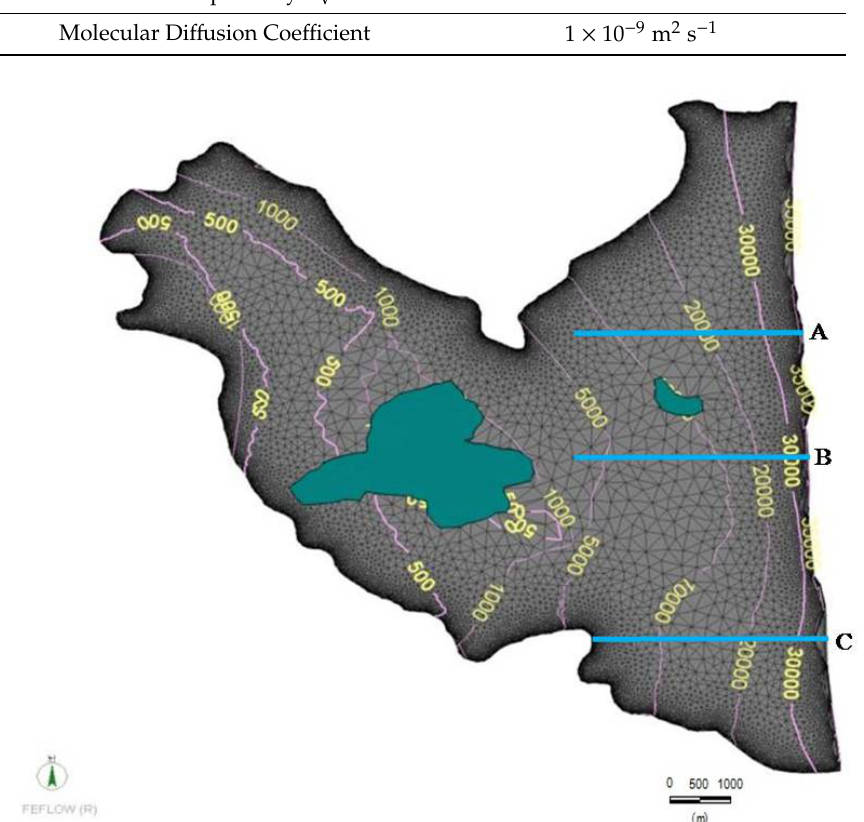
Figure 8. Salinity distribution set up in the groundwater model (mg L − 1 ) and transects A, B and C in which the 15,000 mg L − 1 isosalinity contour displacements are measured on for each model scenario.